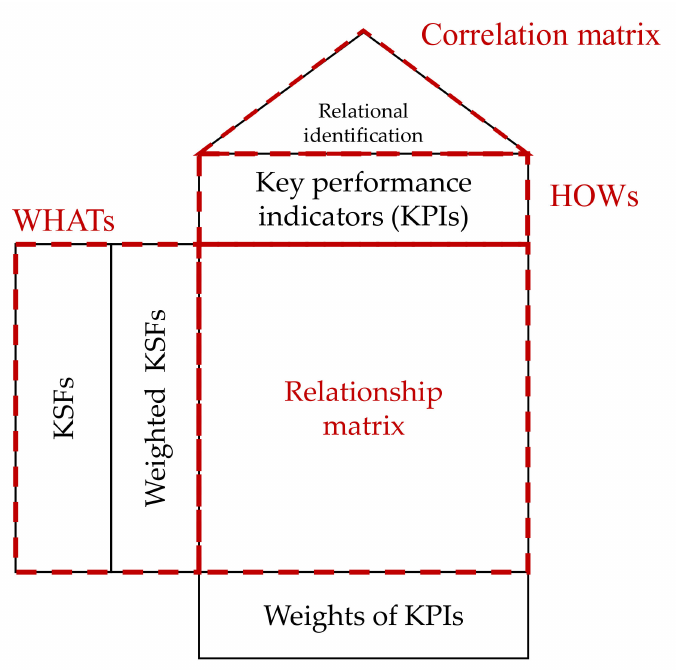
Figure 2. Structure and components of the house following the QFD